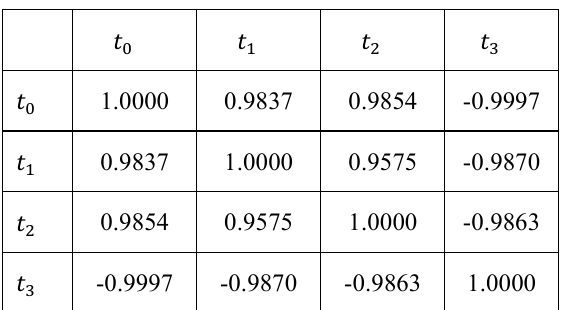
Table 2. Part of correlation matrix elements of SLy5-min original SLy5-min parameter set, and black lines are parameters, . those with the randomized parameter sets. Figure 1(a) shows histogram of the randomized GDR peak energies. 𝑪𝑪 Arrow denotes mean value of the peak energies and its standard deviation, 17.9 ± 1.5